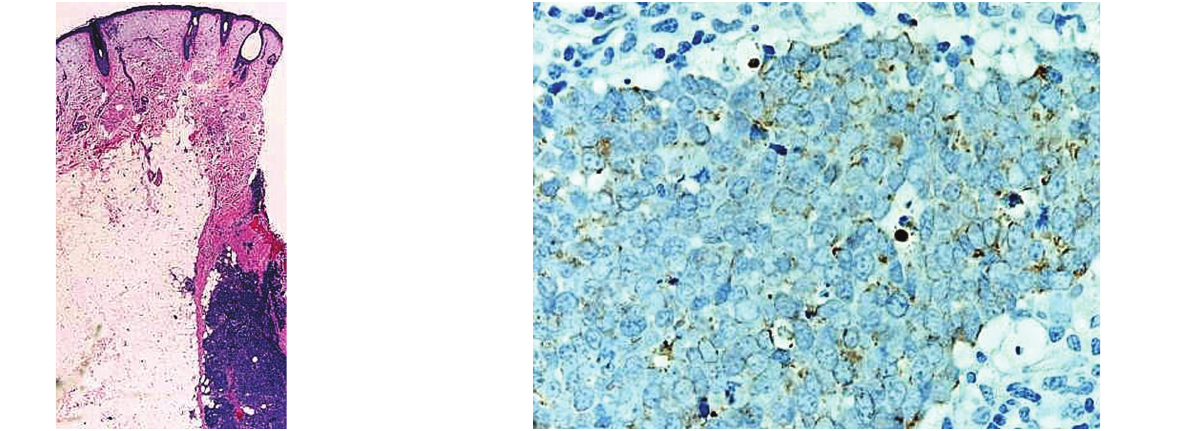
Figure 4: The tumor cells are positive for CK20 and show a “dot- like” pattern of staining.